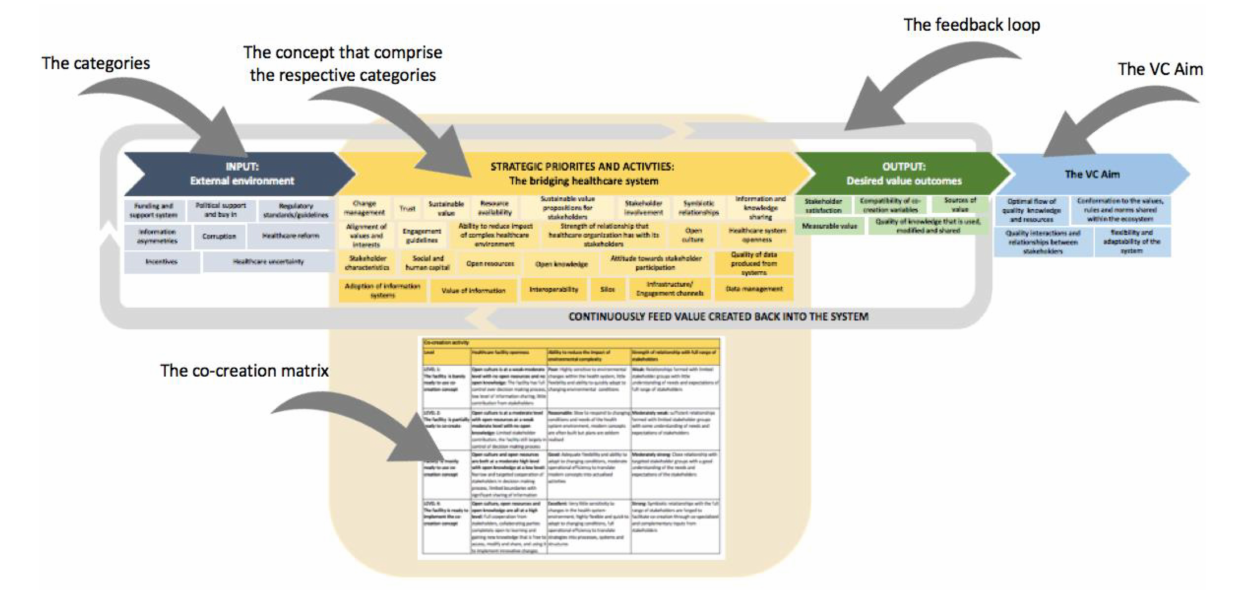
FIGURE 11 | Part one of the ecosystem